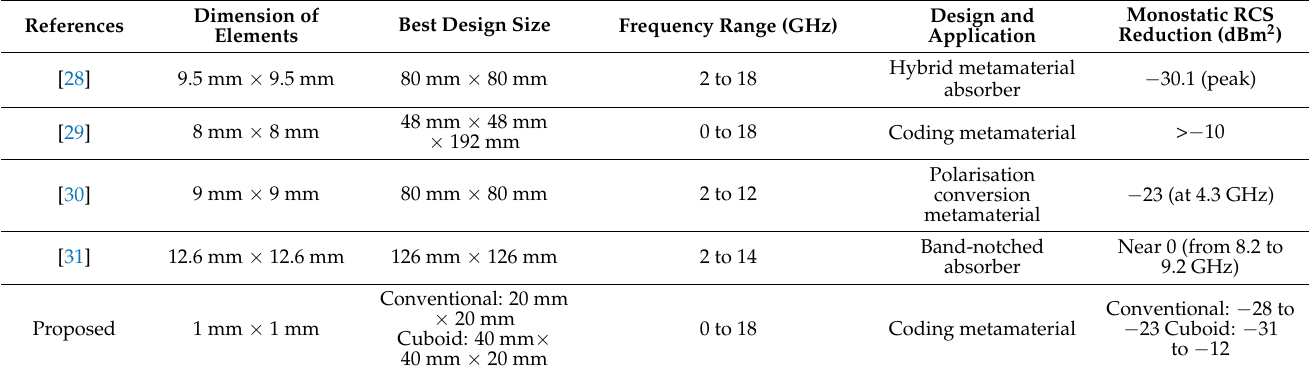
Table 2. Comparison table of previous literature and proposed